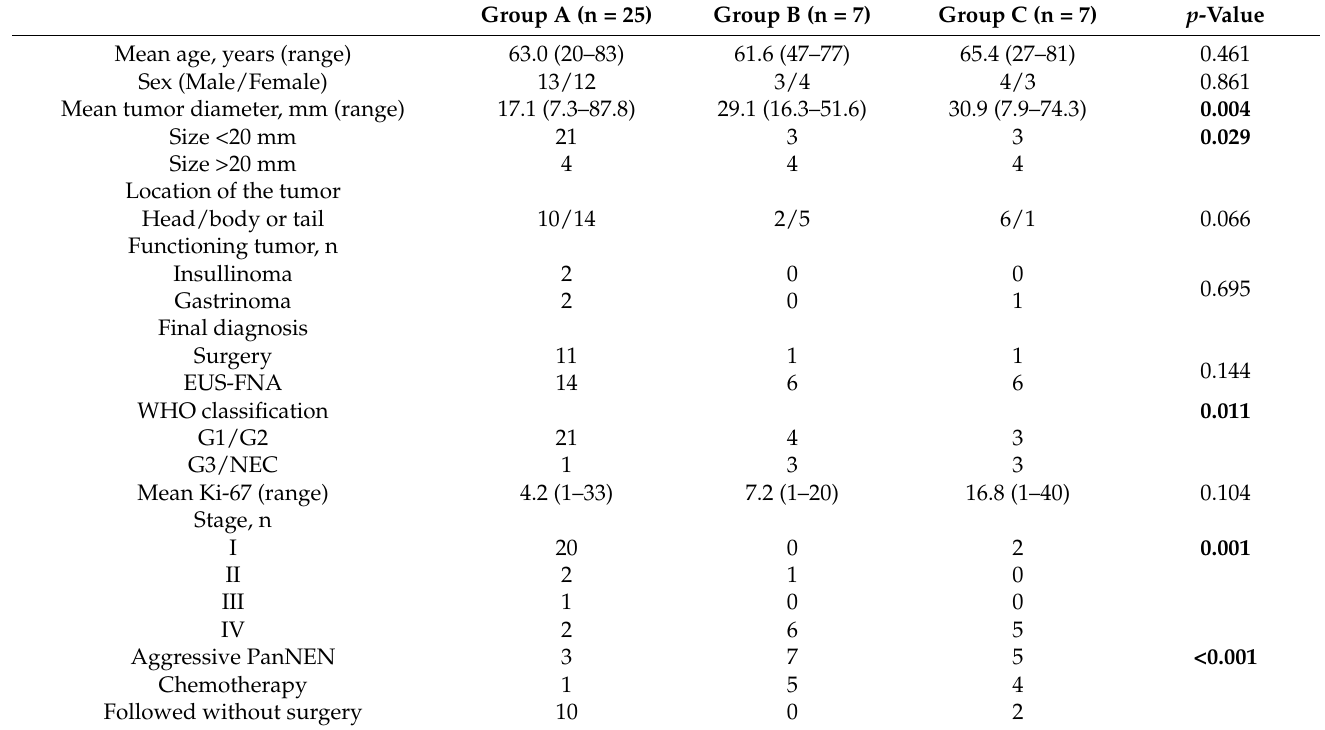
Table 2. Patient characteristics according to enhancement pattern on